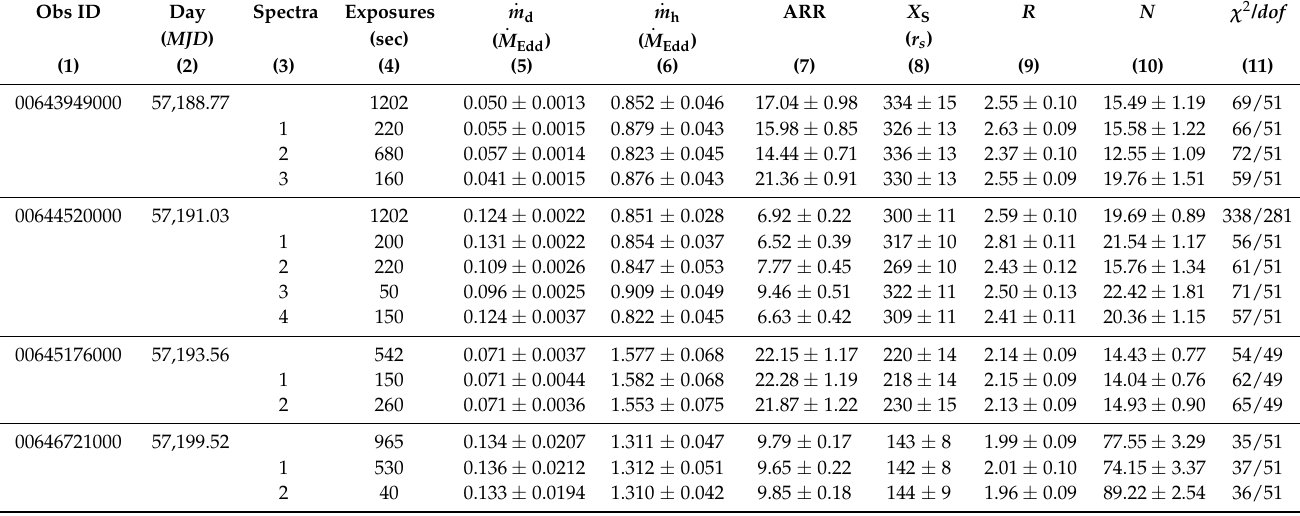
Table 3. Time Resolved BAT